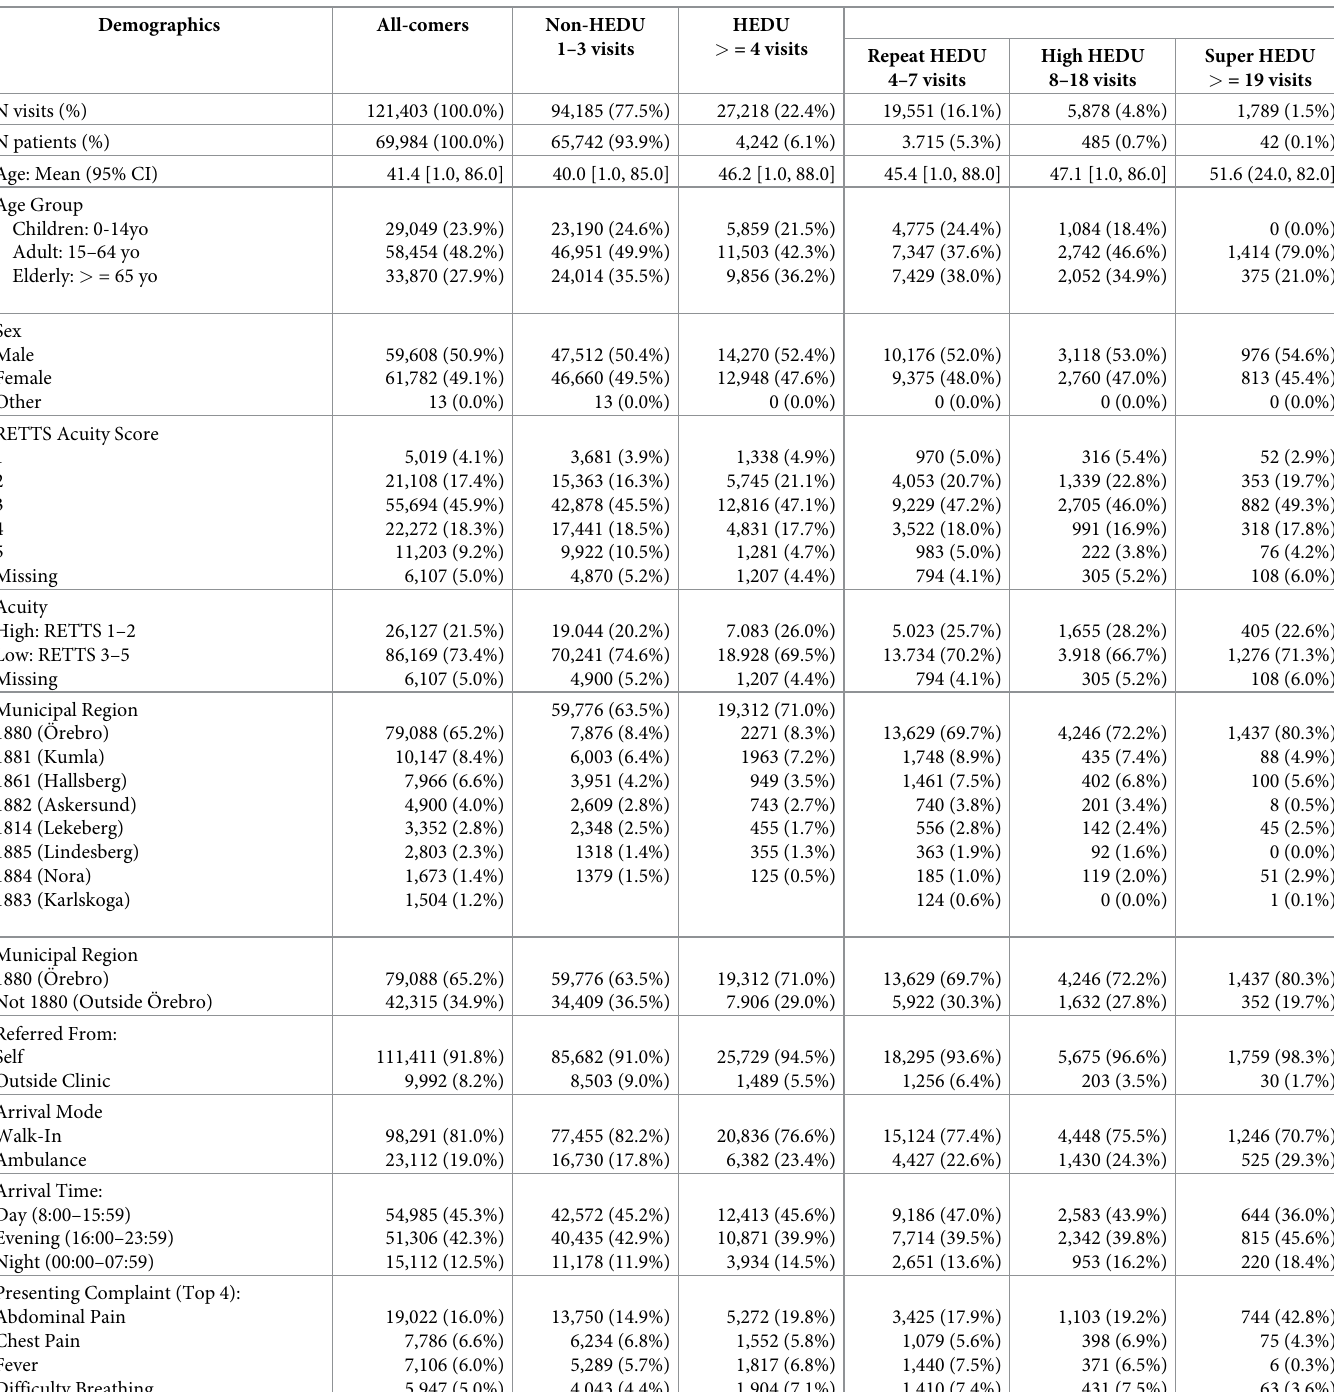
Table 1. Characteristics of January 1, 2018 –December 31, 2019 O¨rebro ED